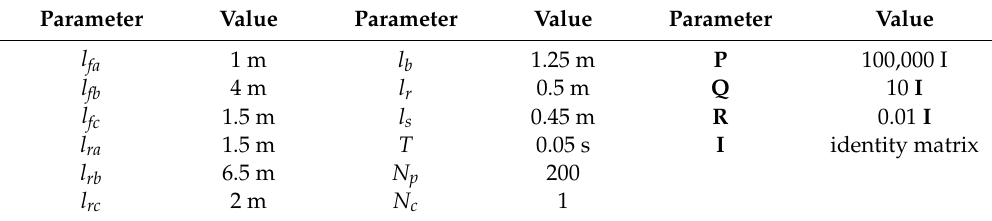
Table 1. The parameters in the simulation